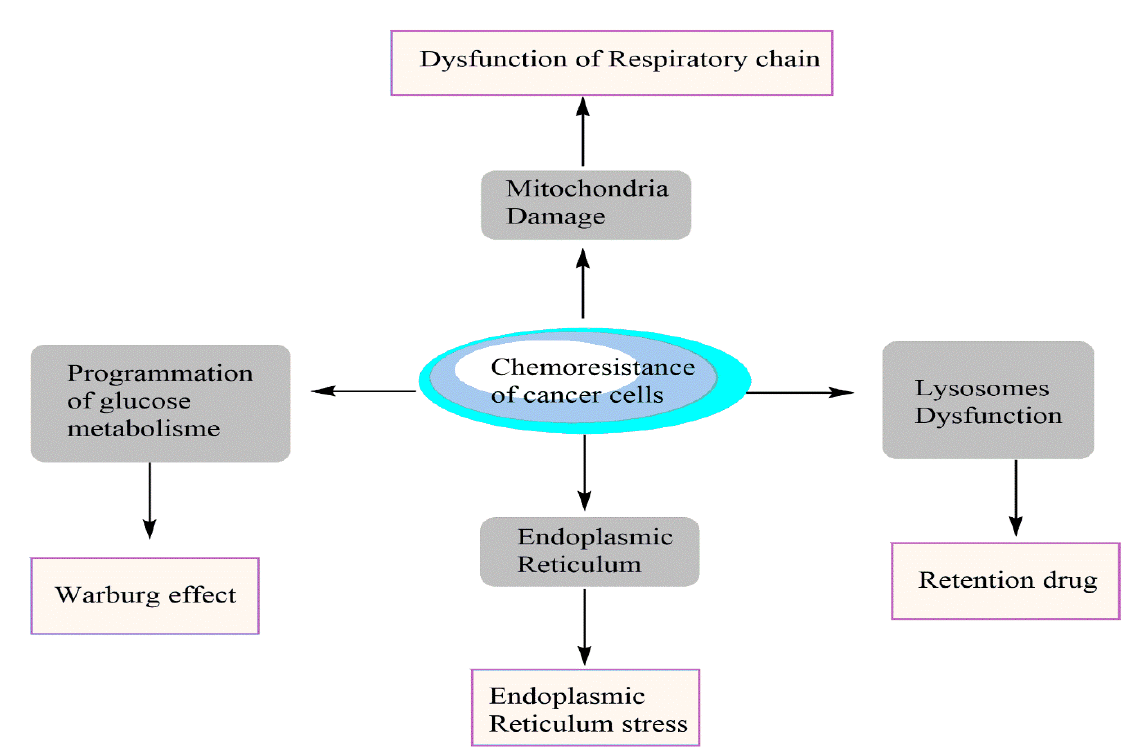
Figure 1. Mechanisms of chemoresistance of cancer cells against anticancer drugs.